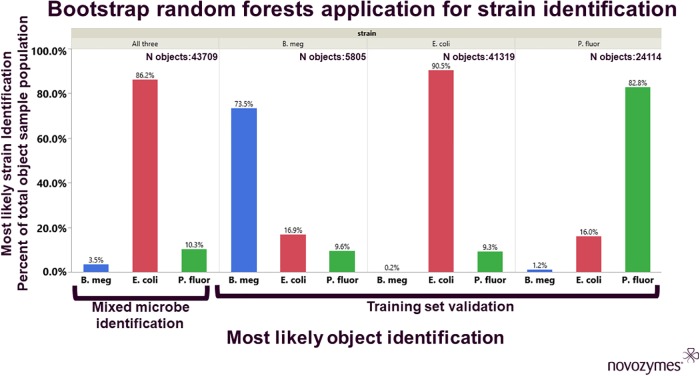
Object feature based strain identification in mixed culture.Data represented is based on the Bootstrap random forest analysis of the total objects (indicated by N) for each microbe species tested. First, subsamples of data from each species in the un-treated control group were used to train the algorithm. Following training, accuracy of the algorithm was determined by re-analysis of all data from each microbe. Data is presented as the percent of objects identified within each training set, so that correctly identified microbes match the identified sub-group, mis-identified microbes do not. Once we validated the rate of correct identification, the algorithm was applied to the mixed-microbe sample object data set, values returned correspond to the percent objects identified as either B. megaterium, E. coli, or P. fluorescens.